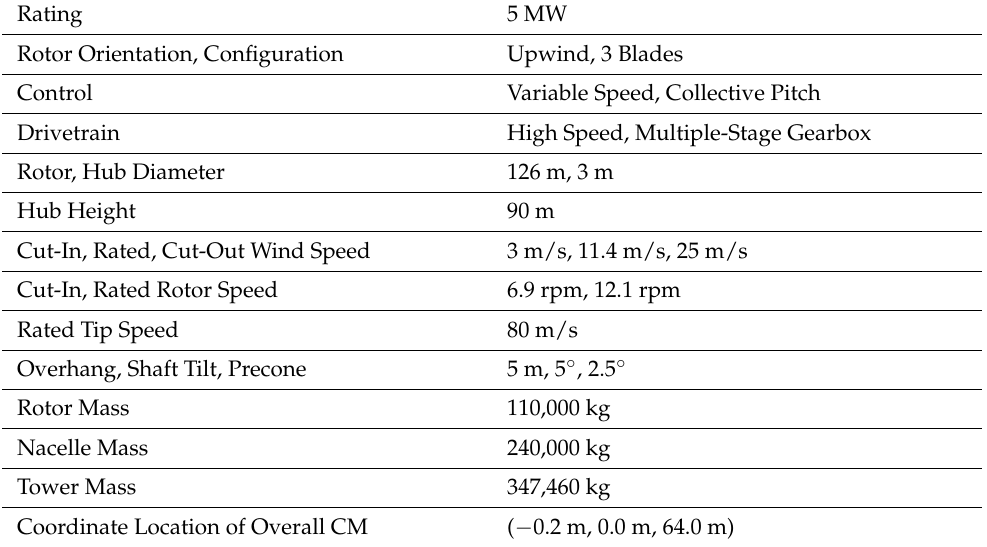
Table 1. Characteristics of NREL 5-MW Baseline Wind Turbine, extracted from [30]. Rating 5